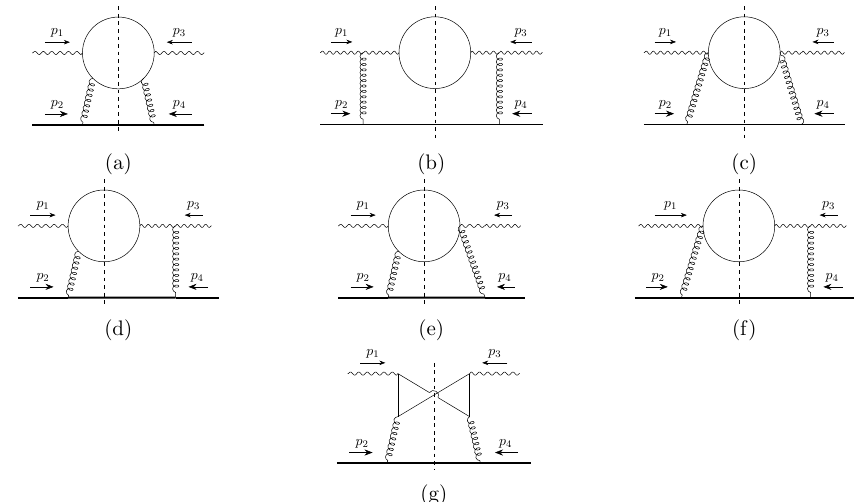
M ∗ . One must add the symmetric 5 λ 3 1